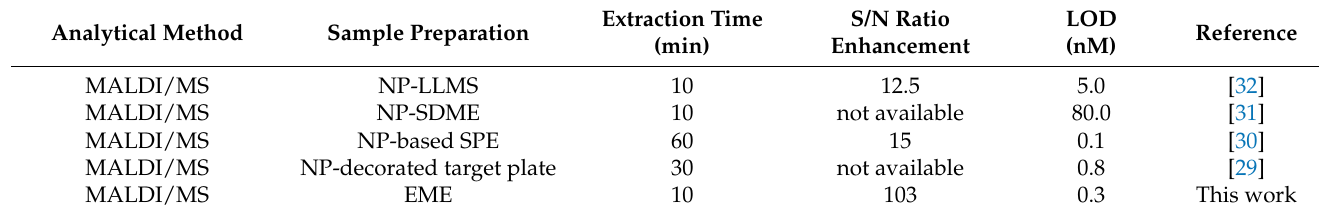
Table 3. Comparison between the proposed method and other reported methods for the determina- tion of insulin in aqueous